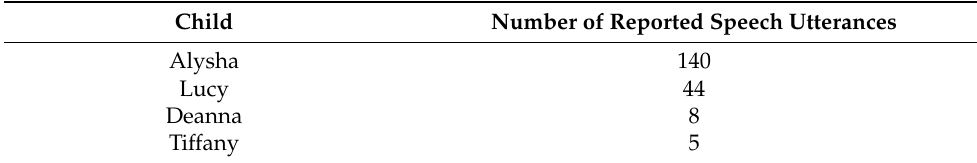
Table 3. Number of reported speech utterances per